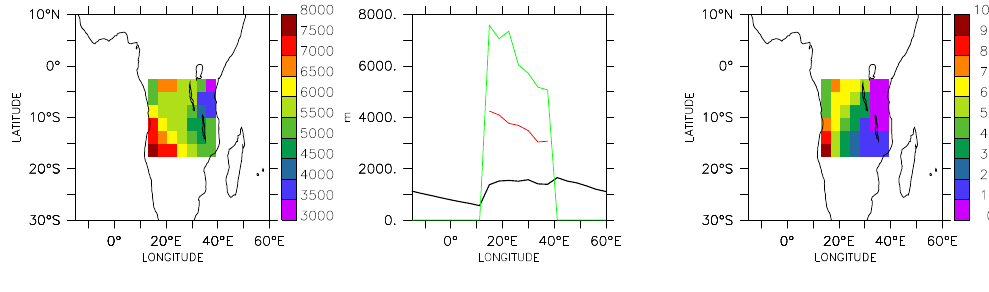
Fig. 8. Injection height of CO 2 emissions: Maximal injection height (m) simulated between the 10 and the 30 July (left); maximal injection height (green), mean injection height of emissions injected above the boundary layer height (red), and mean boundary layer height (dark) averaged between 5 and 20S over 20 days of simulation in July (middle); percentage of cases for which, the injection height passing the boundary layer height, it is finally higher than 4km (right).